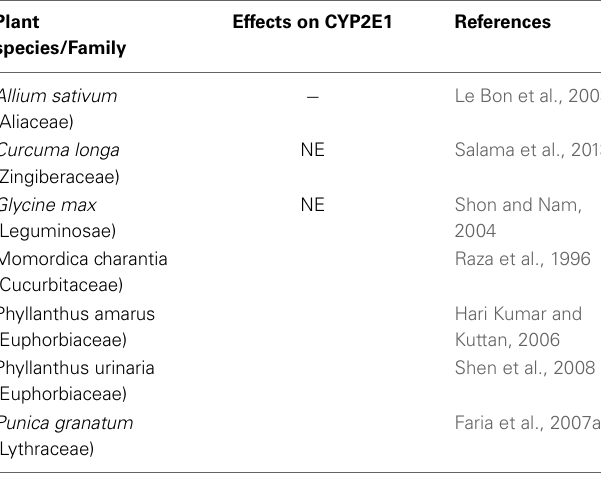
Table 5 | Medicinal plant species listed in RENISUS with reported effects of on